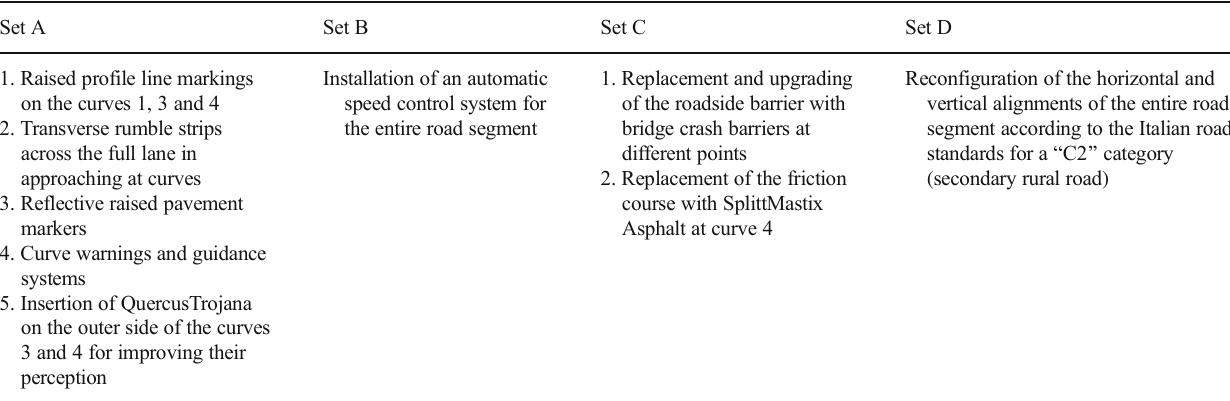
Sets of countermeasures chosen for site PP1 Set A Set B Set C Set D 1. Raised profile line markings on the curves 1, 3 and 4 2. Transverse rumble strips across the full lane in approaching at curves 3. Reflective raised pavement markers 4. Curve warnings and guidance systems 5. Insertion of QuercusTrojana